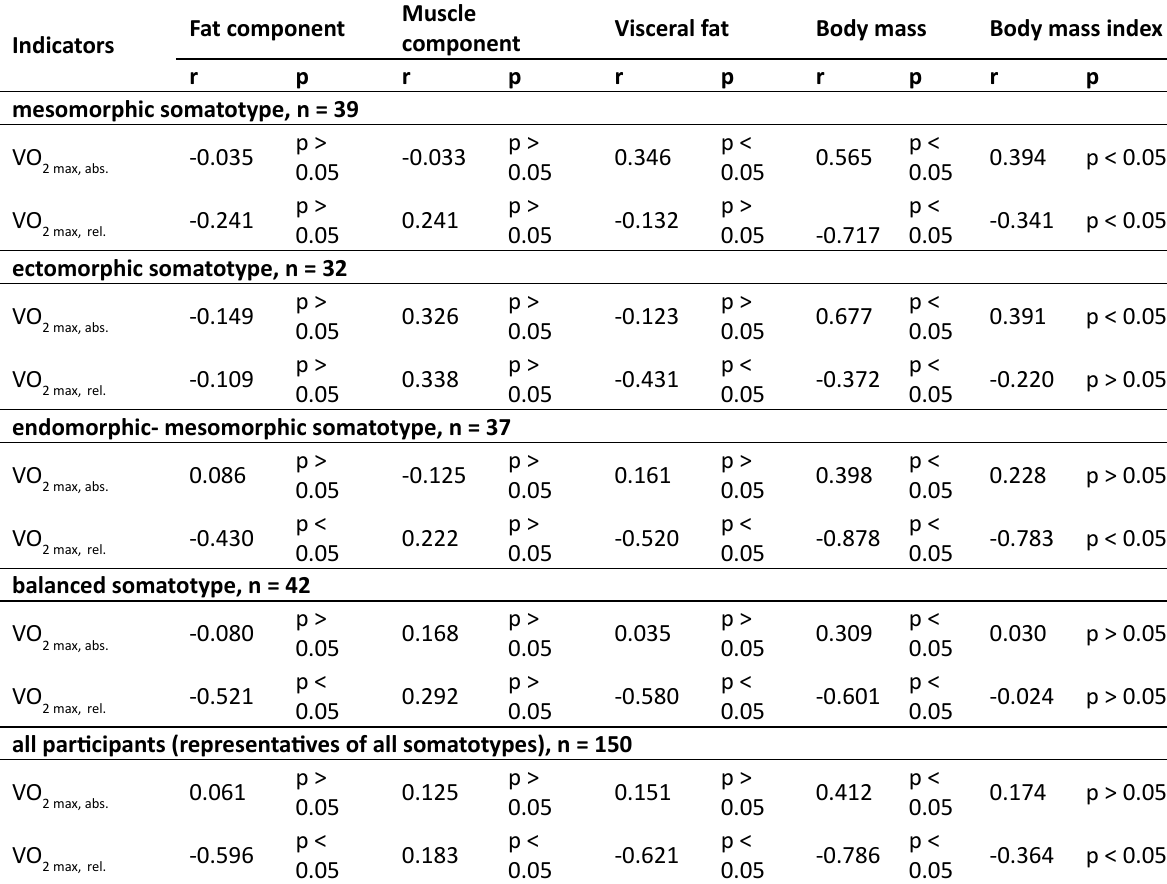
Table 3. Correlation ratio of maximum oxygen consumption indicators with component composition of the body, body mass of men aged 25-35